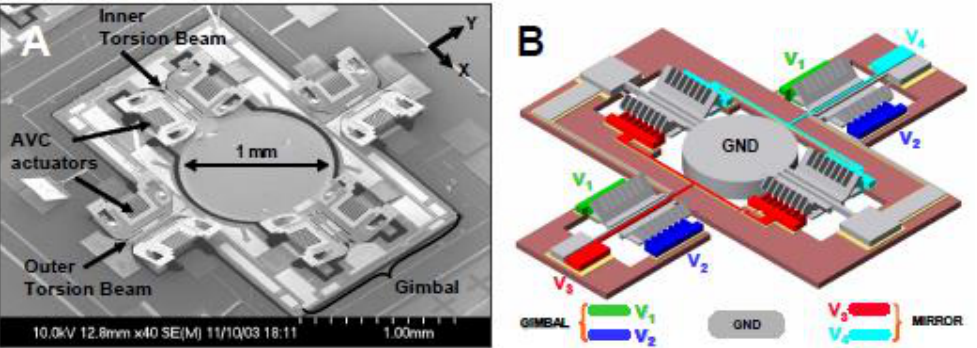
Figure 14. Electrostatically driven micromirror: ( A ) SEM image; ( B ) electrical schematic (taken with the permission of [96] © The Optical Society).